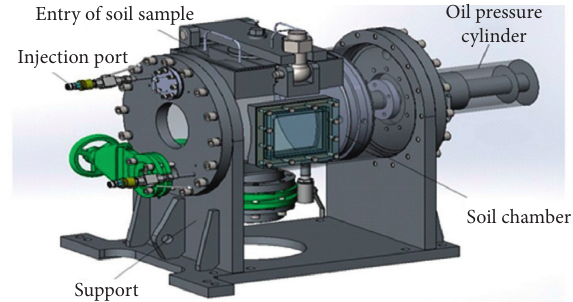
Figure 6: Soil chamber system.